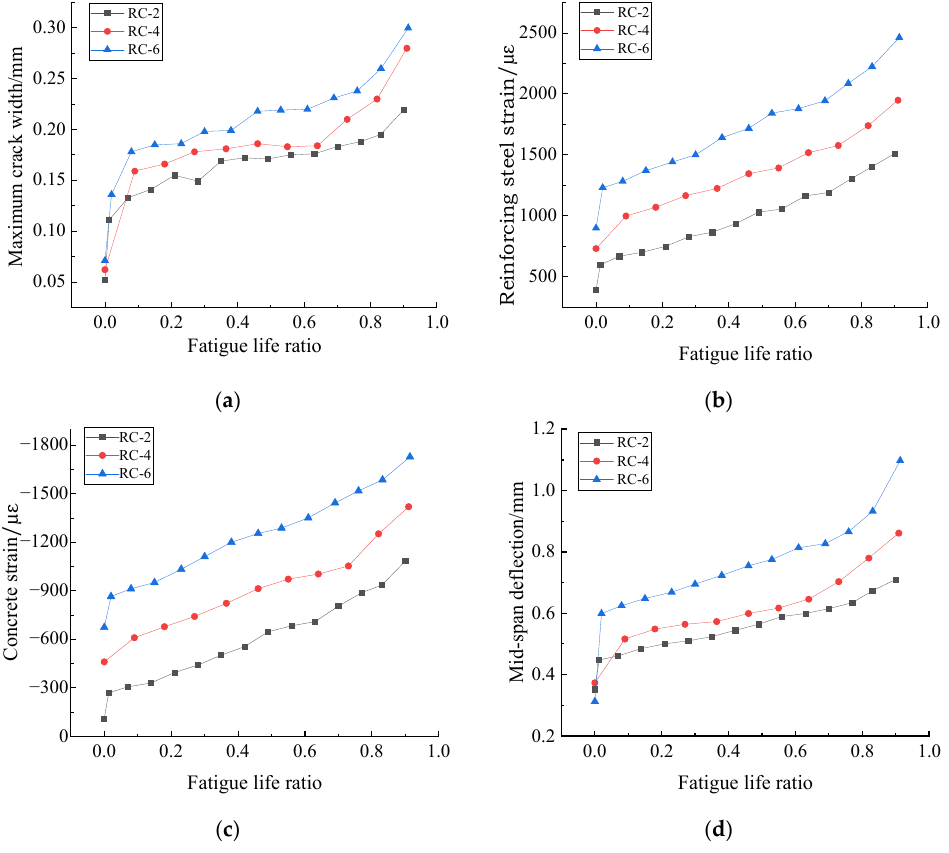
Figure 5. Fatigue performance of RC specimen beams under different numbers of cyclic loading: ( a ) maximum crack width; ( b ) tensile reinforcement strain; ( c ) concrete strain; ( d ) mid-span deflection.